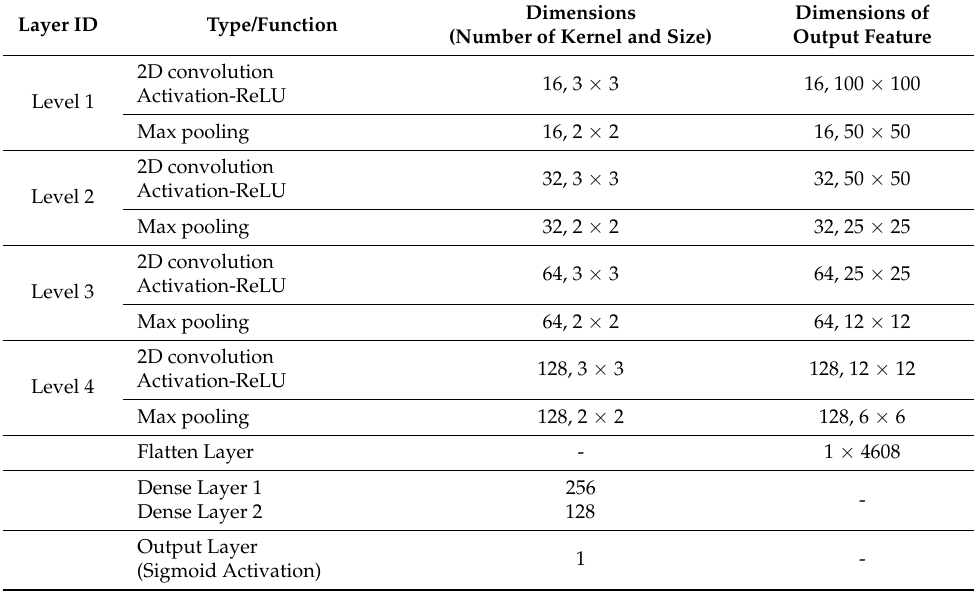
Table 4. Configuration of the best performing DNN.